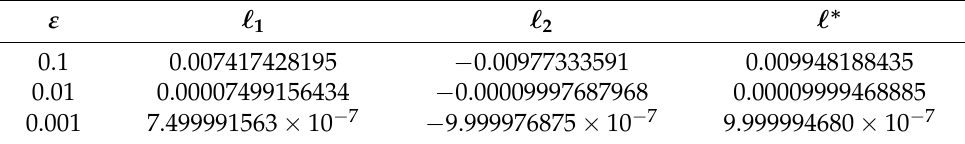
Table 1. Duality.